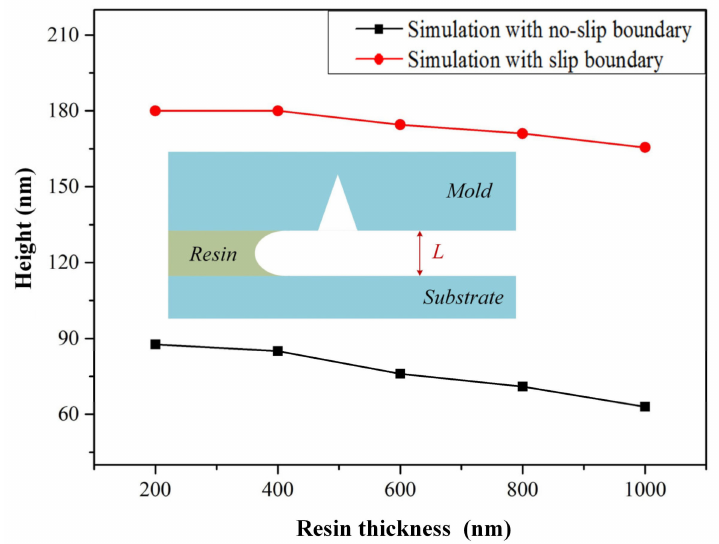
Figure 10. Effect of resin thickness on the filling height of the moth-eye